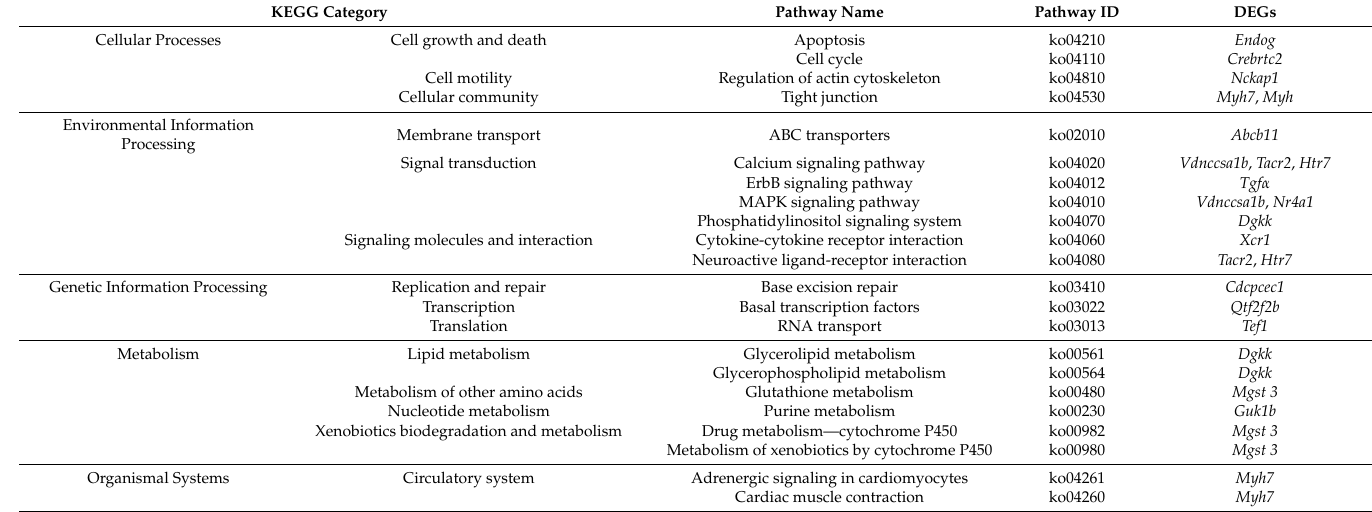
Table 3. Pathways associating with feed conversion efficiency of crucian